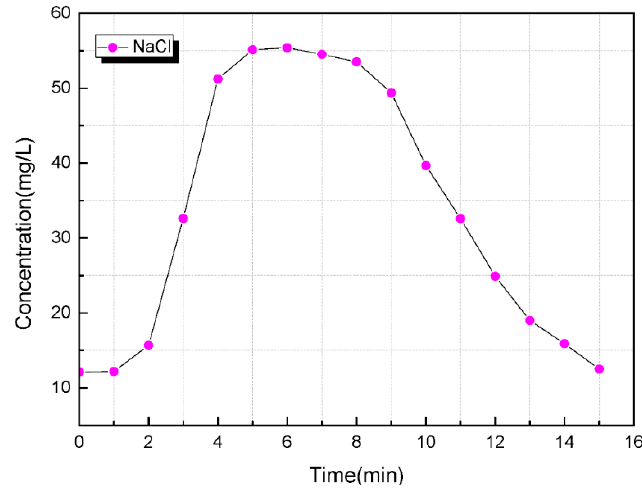
Figure 8. The NaCl concentration–time curve of D3.